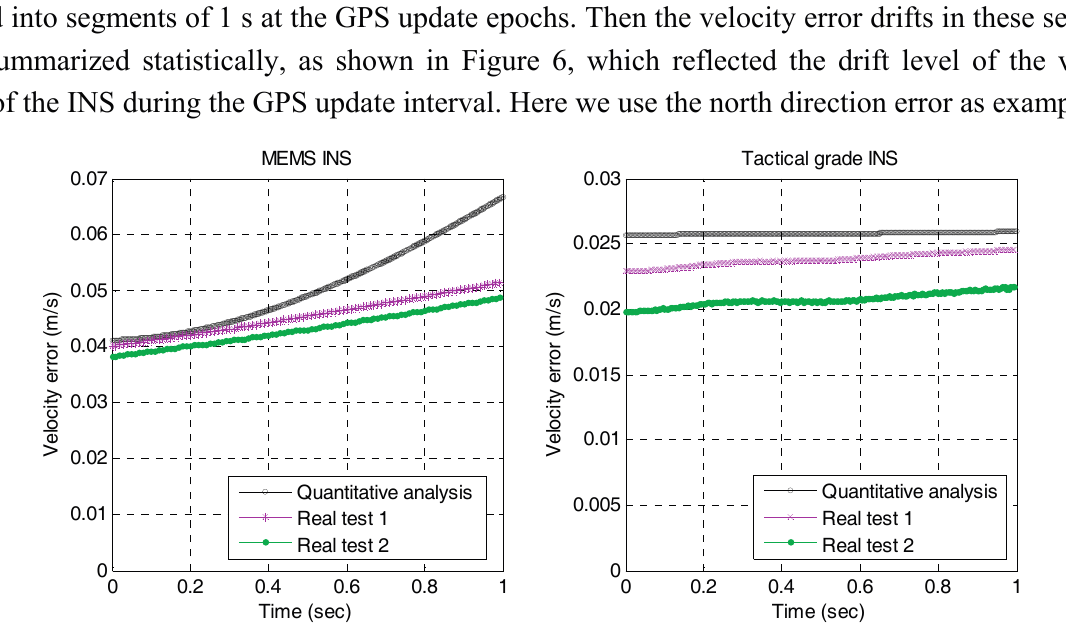
Figure 6. The maneuver-independent velocity errors of the real tests data from different grades of IMUs comparing to theoretical analysis